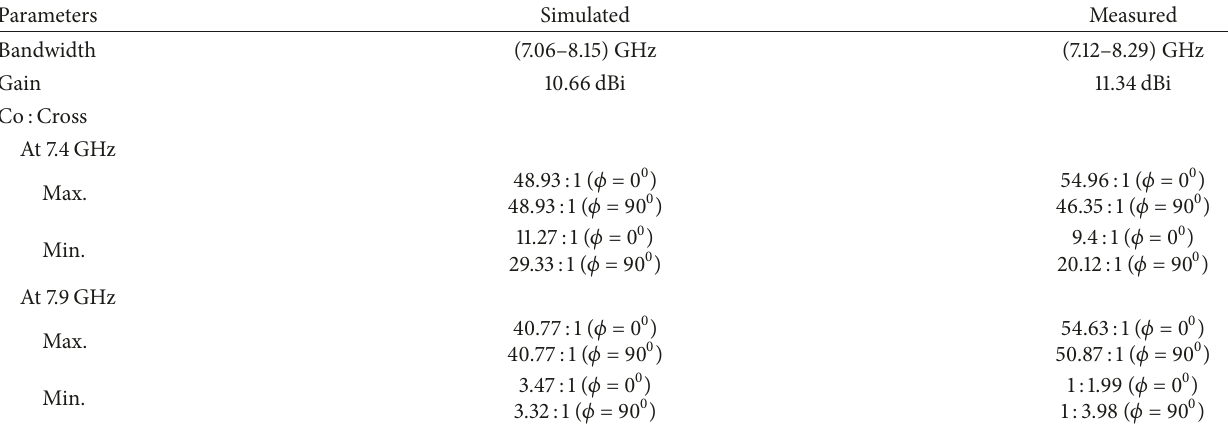
Table 2: Comparison of measured and simulated results of Antenna #4.